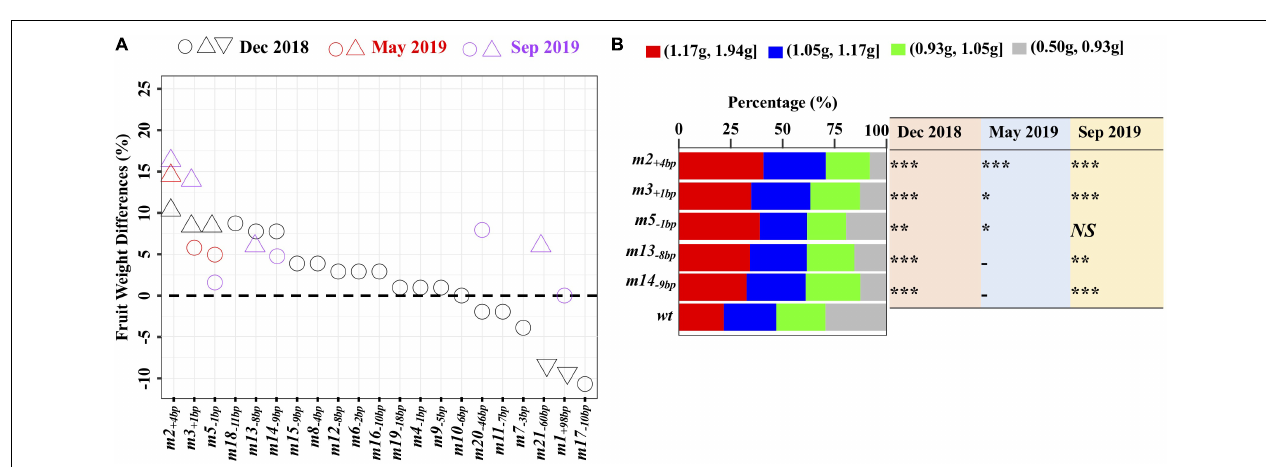
FIGURE 3 | The effects of mutant alleles on fruit weight in three experimental evaluations. (A) Fruit weight differences from LA1589. Each data point represents the fruit weight differences of the mutant (in percentage) to the LA1589. Up and down triangle indicates significantly greater or lower than LA1589 (two-tailed Student’s t -test, P < 0.05), respectively, and the circle represents no significant difference of the mutant relative to LA1589; (B) Percentage distribution of the fruit weight according to fruit weight quartile. Fruits were grouped by their weight into four categories based on the quartiles of fruit weight in all genotypes in each replicate. Each quartile is indicated by a different color, and the fruit range within each quartile is shown in the upper part. A quantitative plot was generated using the data from December 2018. Asterisks denote significant difference (* P < 0.05; ** P < 0.01; *** P < 0.001) of the proportion of small fruit (gray bar) between mutant and LA1589 as determined by chi-squared test. NS, non-significant difference; -, not evaluated.